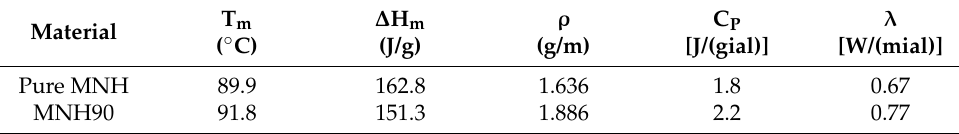
Figure 2. DSC curve of phase change material MNH90. Table 1. Thermal properties for MNH and